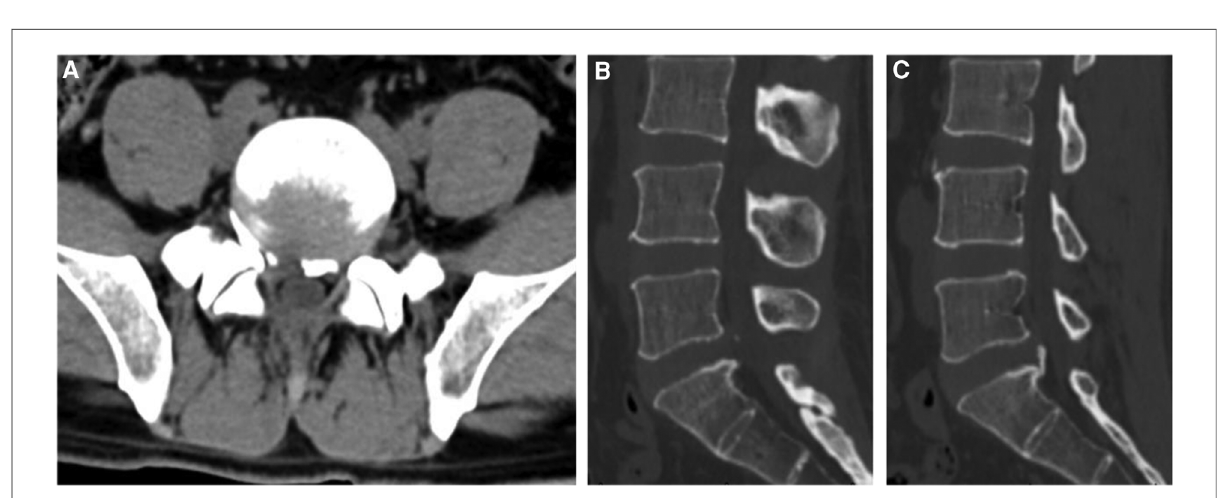
FIGURE 4 Postoperative CT images: ( A ) transverse CT image of the patient in fi gure 2 after the operation shows that the bone fragment that compressed the nerve root on the right side has been removed, ( B ) a sagittal CT scan shows that the right bone fragment has been completely removed, ( C ) the sagittal CT scan shows that the left bone fragment is fi rmly connected to the vertebral body and is not resected during the